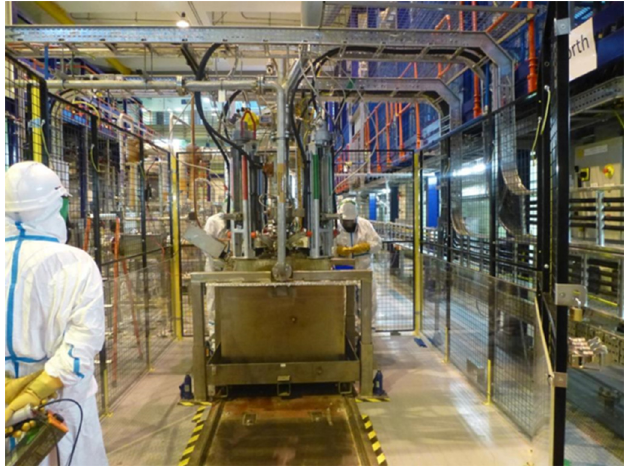
Fig. 7. GeoMelt container.